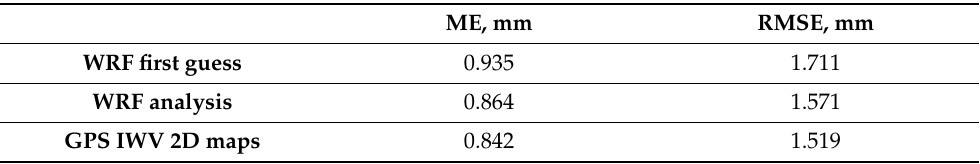
Figure 4. ( a ) Comparison of WRF model analysis calculation vs. radiosonde data. ( b ) Comparison of WRF model first guess vs. radiosonde data. ( c ) Estimated 2D GPS-IWV maps vs. the radiosonde data. Table 2. ME and root mean square error (RMSE) values for first guess, analysis, and GPS 2D maps in comparison to radiosonde